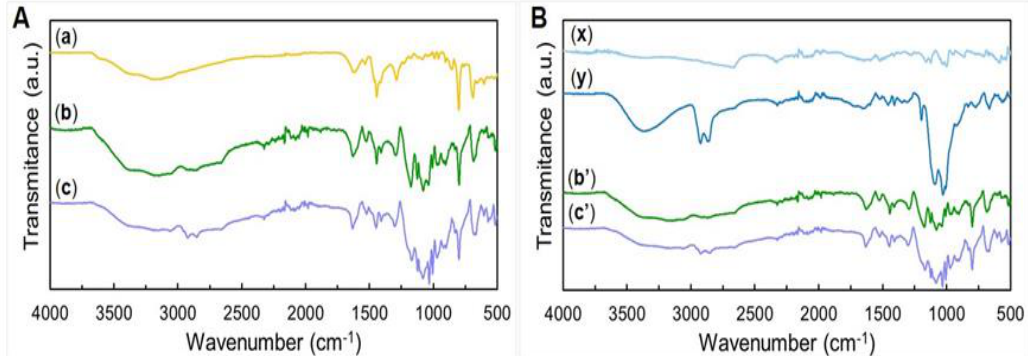
Figure 2. ATR-FTIR spectra of the various samples analyzed. ( A ) Spectra normalized to peak 799 cm −1 of (a) PBI electrospun fibers, and PEDOT:PSS/PBI obtained by (b) spin coating and (c) dip coating. ( B ) Spectra normalized to peak 2324 cm −1 of PEDOT:PSS/PBI samples obtained by (b’) spin coating and (c’) dip coating, (x) PEDOT:PSS pellet and (y) PEDOT:PSS pellet with GOPS.